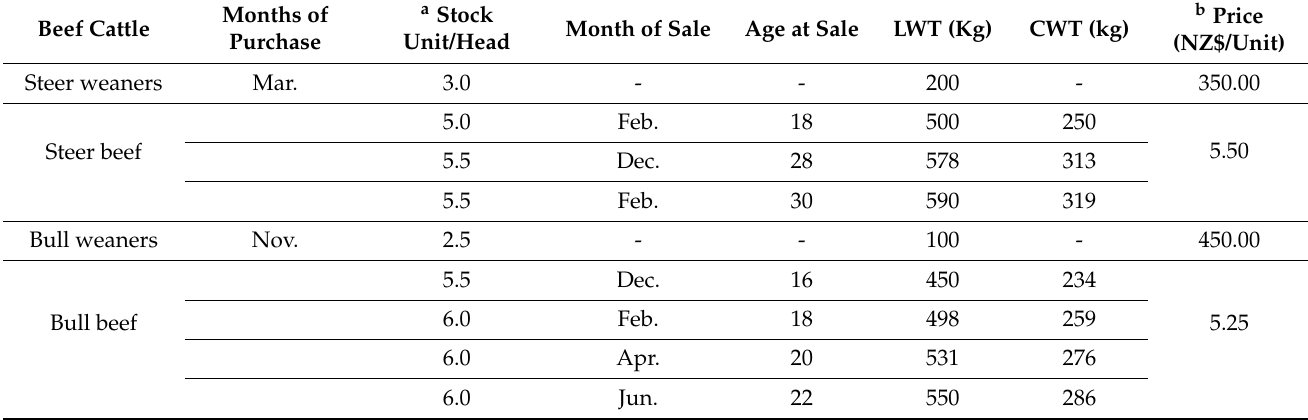
Table 2. For steer and bull weaners, prime steer, and bull beef: the month of purchase, stock unit/head, month of sale for slaughter, age at sale, live weight (LWT), carcass weight (CWT), and unit price (NZ$/unit). Beef